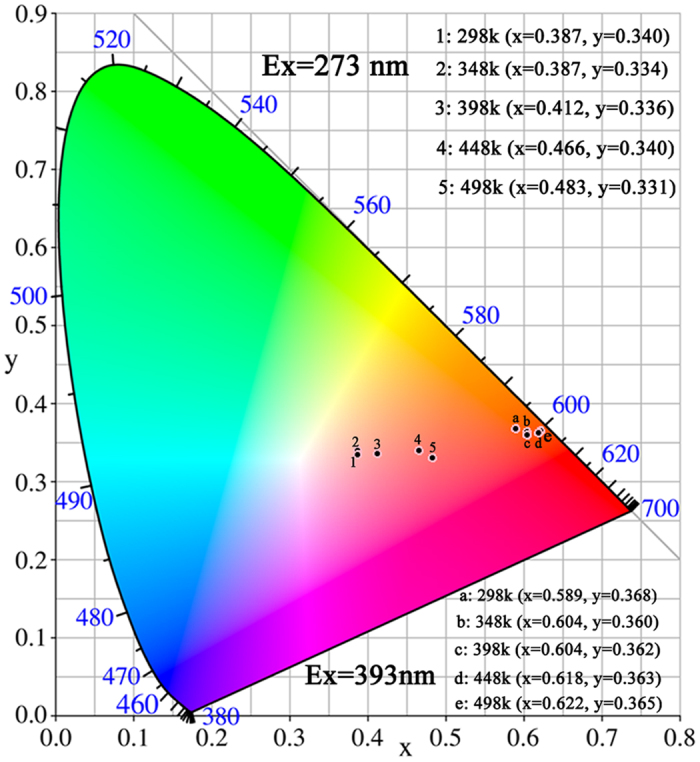
CIE chromaticity diagram of Bi4Si3O12: 2 at%Eu3+ excited by 271 nm and 393 nm at different temperatures.